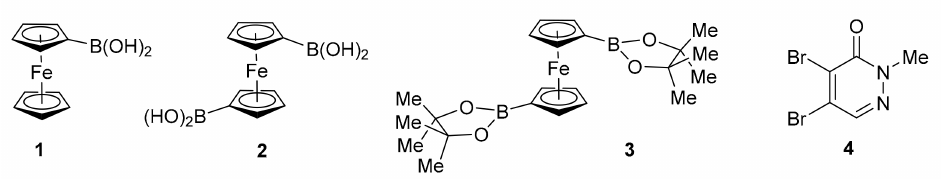
Figure 3. Precursors used in this work to construct the targeted types of ferrocene-containing pyridazinones V – VIII (Figure